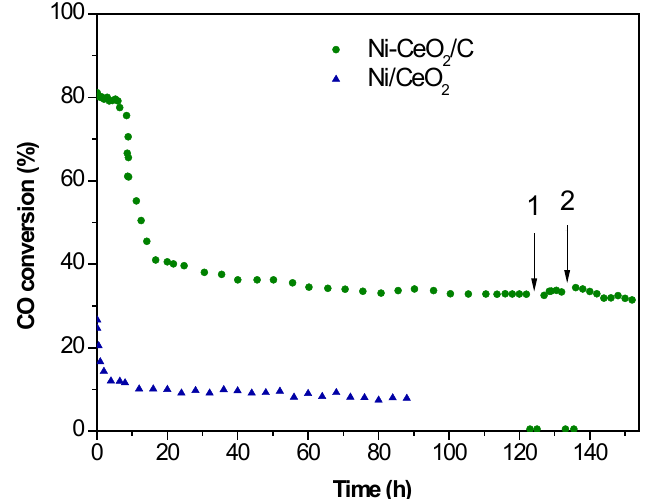
Figure 3. Long term stability test of the prepared catalysts at 250 °C. 1 and 2 start/stop cycles. Gas mixture: 7 mol% CO, 30 mol% H 2 O, 50 mol% H 2 , and 9 mol% CO 2 balanced in He.